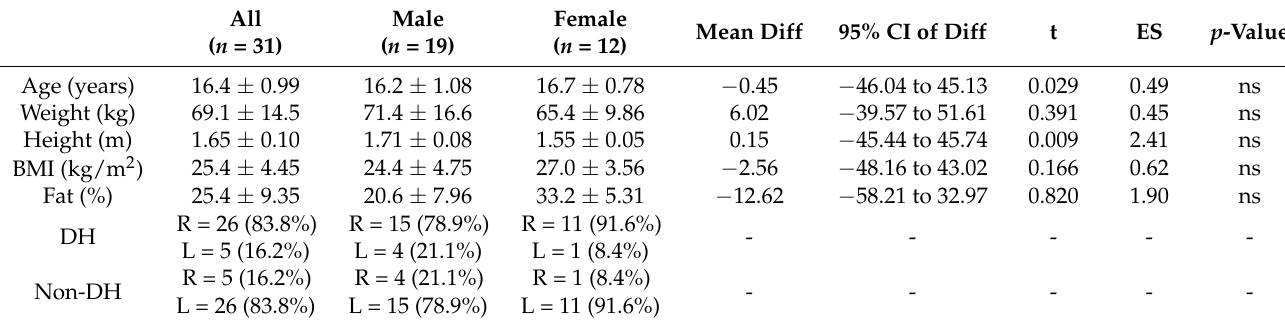
Table 1. Sample characterization.